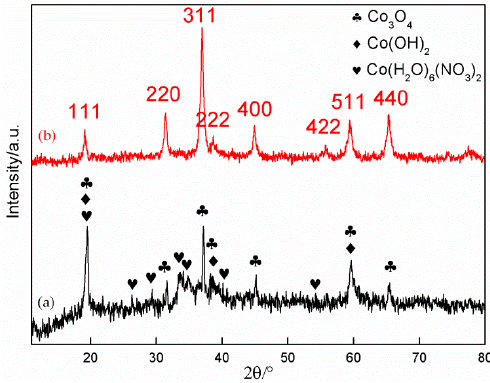
Figure 5. XRD patterns of sample D: ( a ) before annealing; ( b ) after annealing.